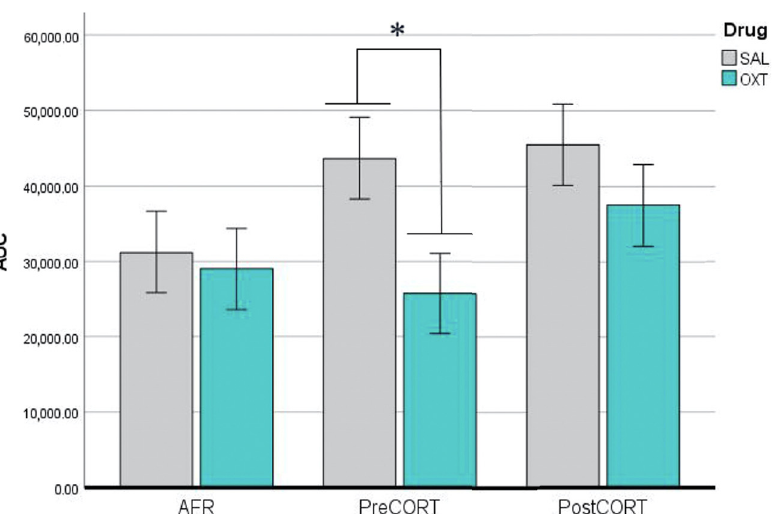
Figure 3. Area Under the Curve (AUC). The AUC was calculated following the trapezoidal rule for plasma corticosterone concentration in subjects that were involved in the Restraint Stress test. Subjects: AFR-SAL, AFR-OXT, PreCORT-SAL, PreCORT-OXT, PostCORT-SAL and PostCORT-OXT ( n = 8 for each group) (* p < 0.05). Error bars indicate mean ± SEM .